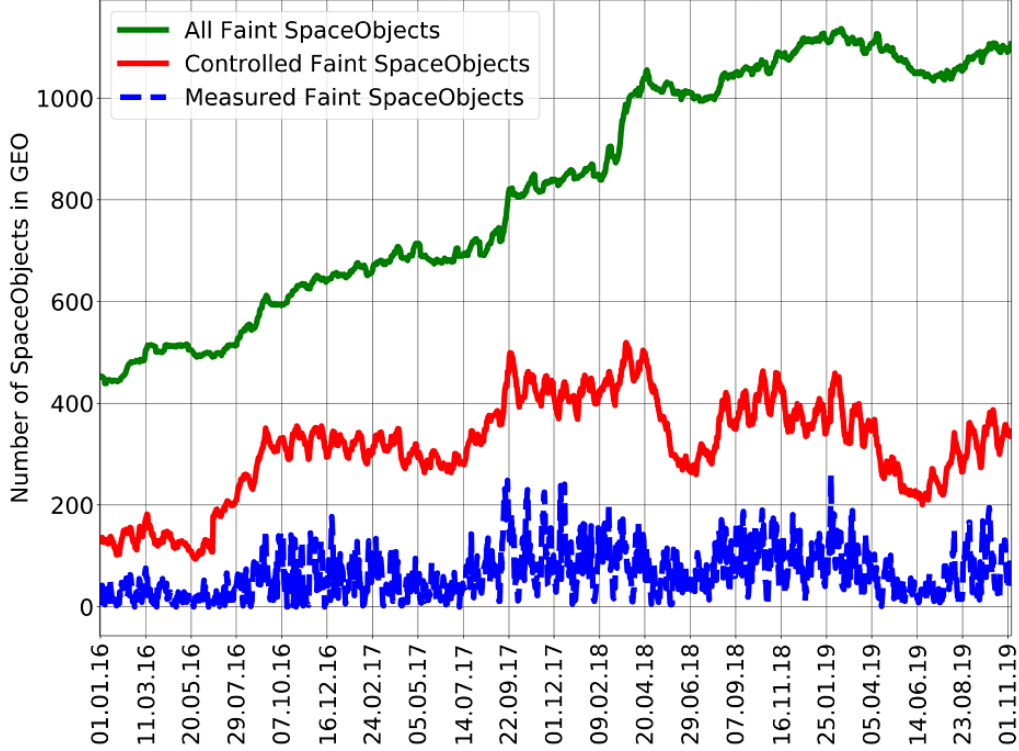
Figure 6. State of the ISON database in part of faint GEO-objects yearly. Here are shown the parameters of the catalogue of faint GEO objects for the 4 years period. Curves of different color indicate total number of objects fainter 15.5 m (green), number of objects measured during current night (blue), and number of objects with accurate orbits (red). Vertical axis - number of objects, horizontal axis-dates.